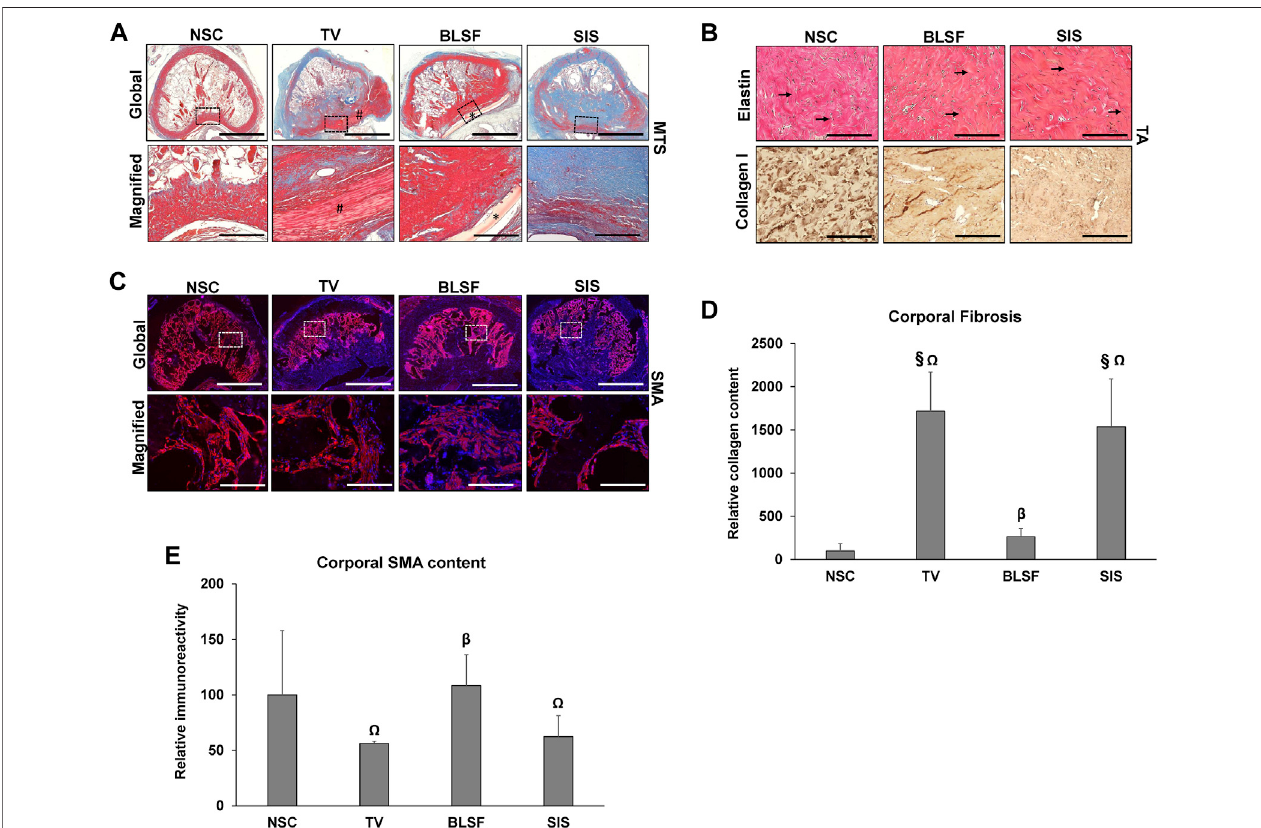
FIGURE 3 | Histological, immunohistochemical and histomorphometric assessments of control and reconstructed penile tissues. (A) Representative cross- sectionalviewsofMasson ’ strichrome(MTS)-stained,peniletissuesrepairedwithimplantgroupsat3 monthspost-oportreatedasNSC.Grosscross-sectionsofpenile tissues are presented in the top row with magni fi ed views (boxed) of control or graft sites displayed in the second row. ( # ) denotes autologous TV fl aps. (*) demarcates residualBLSF graftfragments. Scalebars for1stand 2ndrowsineach panelare3 mm and600 μ m,respectively. (B) Top row:VerhoeffVanGieson(VVG) staining of elastin fi bers (arrows) in NSC and regenerated tunicaalbuginea from BLSF and SISgroups. Bottom row: IHC assessmentsofcollagentype Iexpression (brown, HRP labeling) in samples described in the top row. Specimens were also counterstained with hematoxylin to visualize nuclei (blue). Scale bars for both rows are 200 µm. (C) IHCevaluationsofSMAproteinexpressioninspecimensdetailedin (A) withgross(toprow)andmagni fi ed(boxed)areasofthecorpora(bottom row).SMAexpressionis labeled in red (Alexa Fluor 594 labeling) with DAPI nuclear counterstain displayed in blue. Scale bars for top and bottom rows are 3 mm and 200 μ m, respectively. (D) QuantitationoftotalcollagencontentincorporaofMTS-stainedspecimensdescribedin (A) . (E) QuantitationofSMAexpressionincorporafromgroupsdescribedin (C) . For both panels (D,E) , N (cid:1) 3 – 5 animals per datapoint wereassessed.Values were normalized toNSC levels and are presented asmean ± SD. Datawere analyzed with Kruskal Wallis and post-hoc Dunn ’ s test to determine signi fi cance. ( Ω ) (cid:1) p < 0.05 in comparison to BLSF group. ( § ) (cid:1) p < 0.05 in comparison to NSC. ( β ) (cid:1) p > 0.05 in comparison to NSC. BLSF, bi-layer silk fi broin scaffold; TV, tunica vaginalis; SIS, small intestinal submucosa; NSC, nonsurgical controls; SMA, α -smooth muscle actin; HRP, horseradish